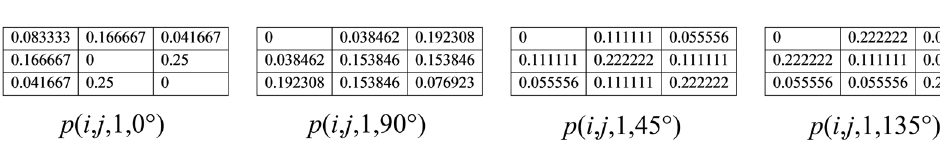
Figure 4. Normalized GLCM examples of the sample image.